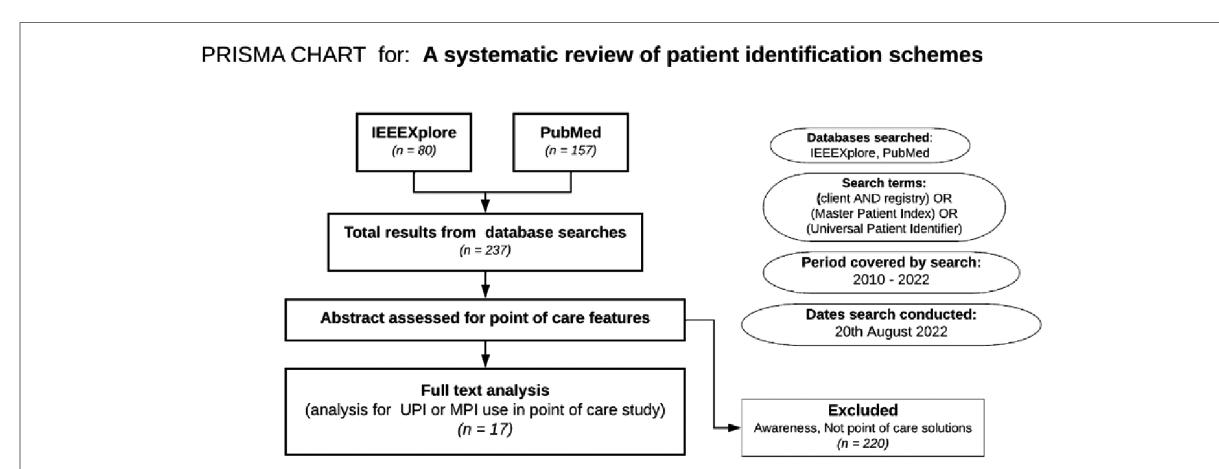
FIGURE 1 PRISMA for literature search approach for determining candidates for patient ID